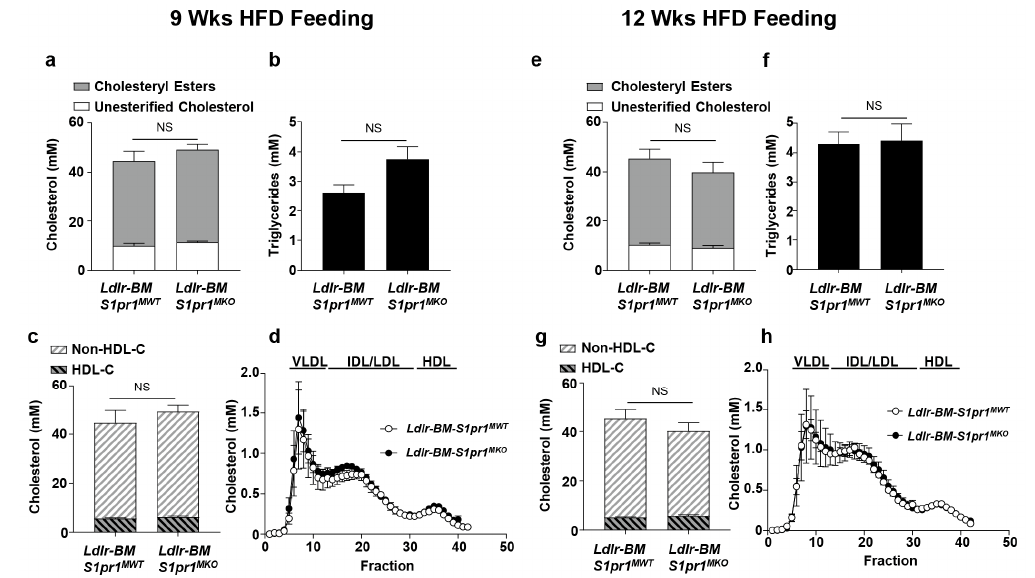
Figure 2. Plasma lipid and lipoprotein analysis in Ldlr BM S1pr1 MKO and Ldlr BM S1pr1 MWT mice fed a high fat diet (HFD) for nine or twelve weeks. Ldlr BM S1pr1 MKO and control Ldlr BM S1pr1 MWT generated by transplanting bone marrow (BM) from either S1pr1 MKO or control S1pr1 MWT mice into lethally irradiated Ldlr KO recipients as described in the Methods section. After four weeks of recovery from BM transplantation, chimeric mice were fed a HFD for ( a – d ) 9 weeks or ( e – h ) 12 weeks; ( a , e ) plasma levels of cholesterol ester (grey bar) and unesterified cholesterol (white bar); ( b , f ) triglycerides and ( c , g ) High density lipoprotein (HDL)-associated cholesterol (HDL-C) (black and grey striped bar) and non-HDL-C (white and grey striped bar). Group sizes are n = 13 Ldlr BM − S1PR1 − MWT and n = 14 Ldlr BM S1pr1 MKO mice fed for 9 weeks and n = 19 Ldlr BM − S1PR1 − MWT and n = 10 Ldlr BM S1pr1 MKO mice fed for 12 weeks; ( d , h ) average plasma lipoprotein total-cholesterol profiles for n = 3 Ldlr BM − S1PR1 − MWT (white symbol) and n = 10 Ldlr BM S1pr1 MKO mice (black symbol) fed for either 9 or 12 weeks as indicated. Bars above the profiles indicate fractions in which purified human lipoproteins elute. Results are shown as means ± SEM. Data in panels b and f were analyzed by the Mann–Whitney rank sum test, while data in all other panels were analyzed by two-way ANOVA with Tukey’s multiple comparisons test. No statistically significant differences (NS) between Ldlr BM S1pr1 MKO and Ldlr BM S1PR1 MWT mice were